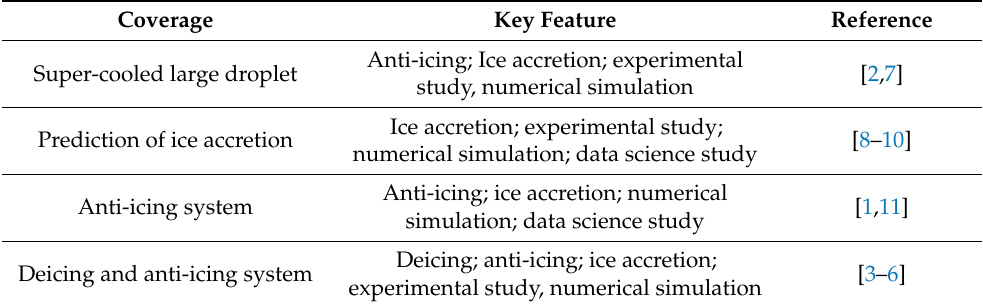
Table 1. Coverage of the Special Issue on Deicing and Anti-Icing of